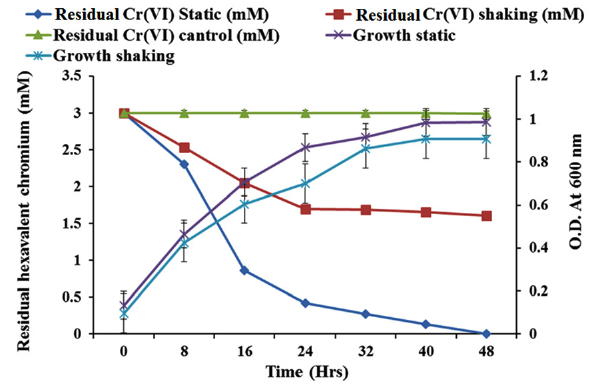
Fig. 2. Reduction of Cr(VI) and cell growth under static and shaking condition by SN6